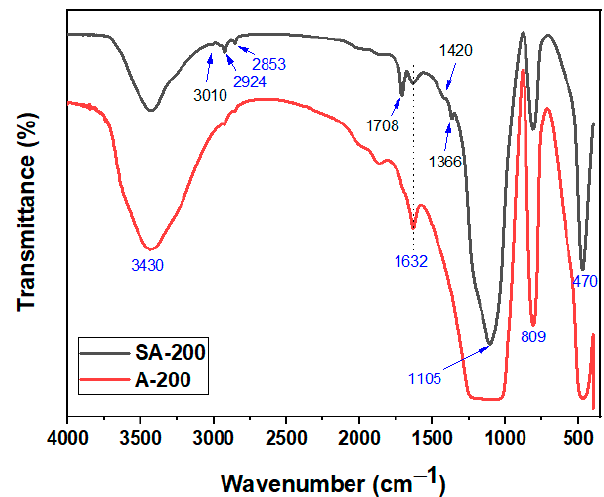
Figure 3. Fourier transform infrared (FTIR) spectra of fumed silica before (A200) and after Figure3. Fouriertransforminfrared(FTIR)spectraoffumedsilicabefore(A200)andaftermodification(S-A200). modification (S-A200).